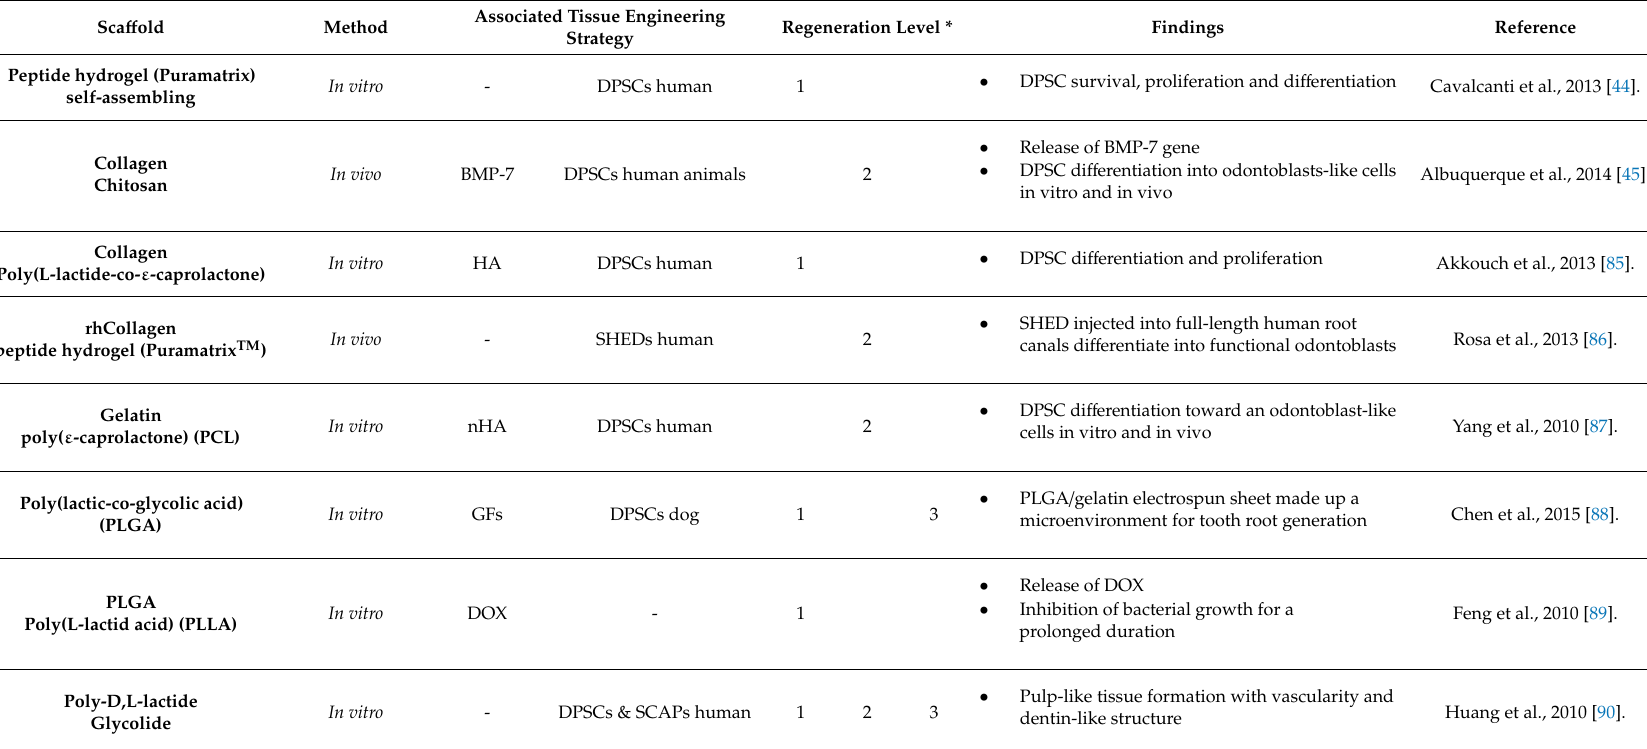
Table 2. Composite instructive polymer sca ff olds for di ff erent levels of endodontic